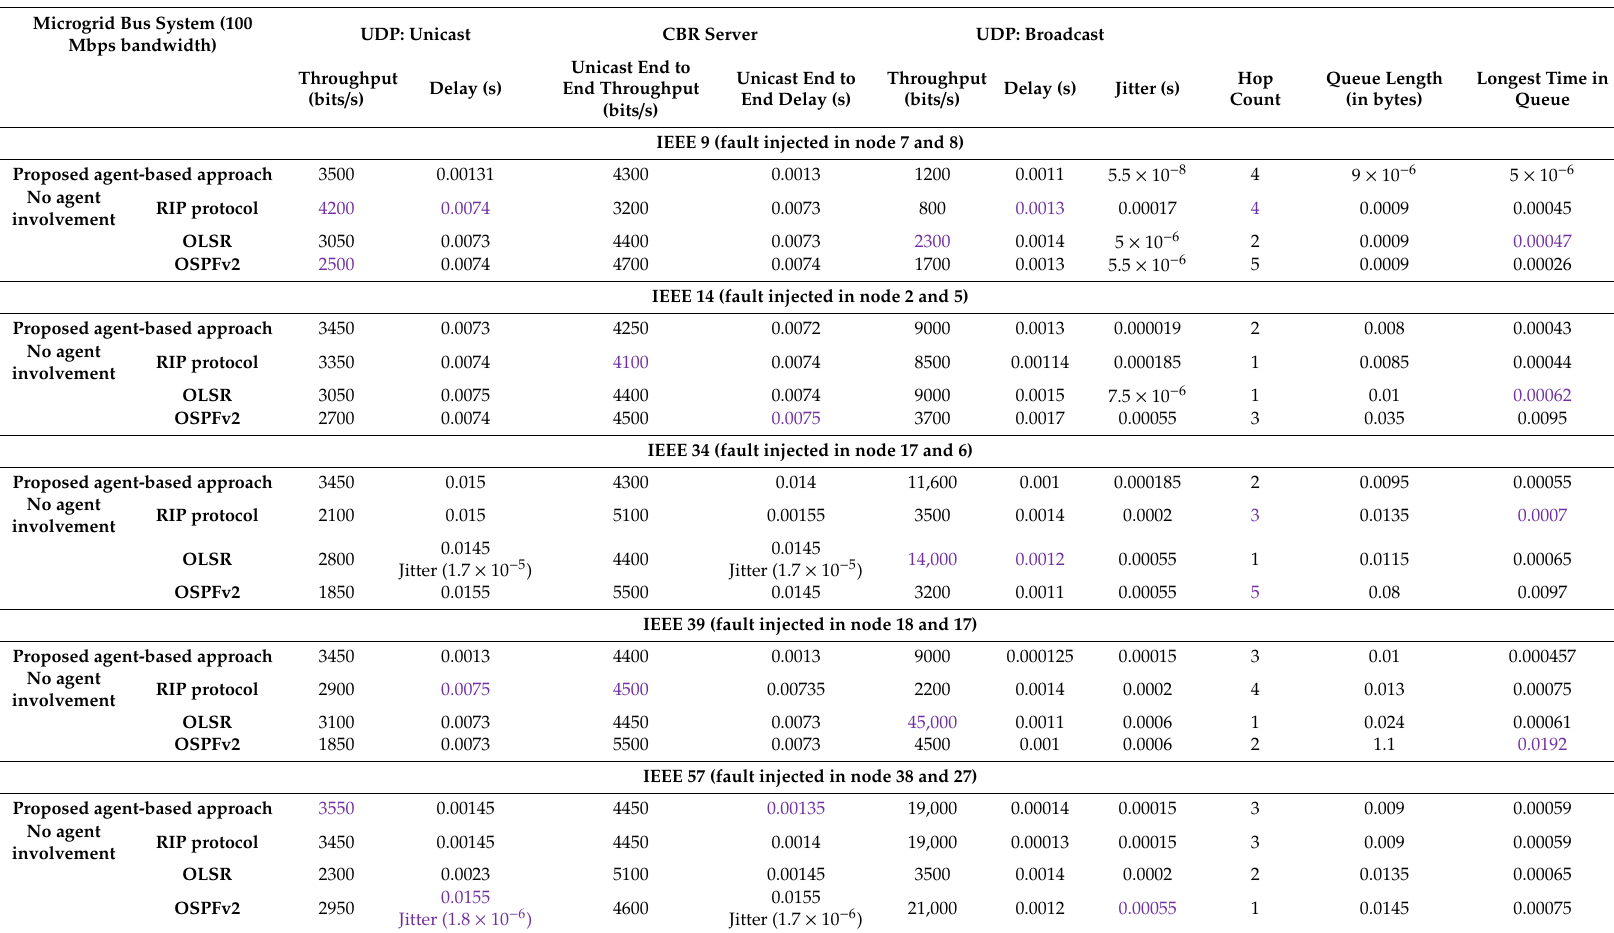
* The table highlights the changes compared with Table 3 and the visible changes are highlighted using violet color in this